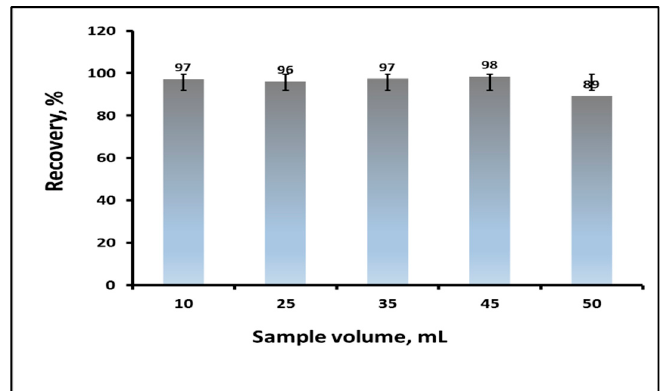
Figure 3. Effect of the eluent volume on the desorption of carbaryl from A100 Al-based MOFs ( n = 3).